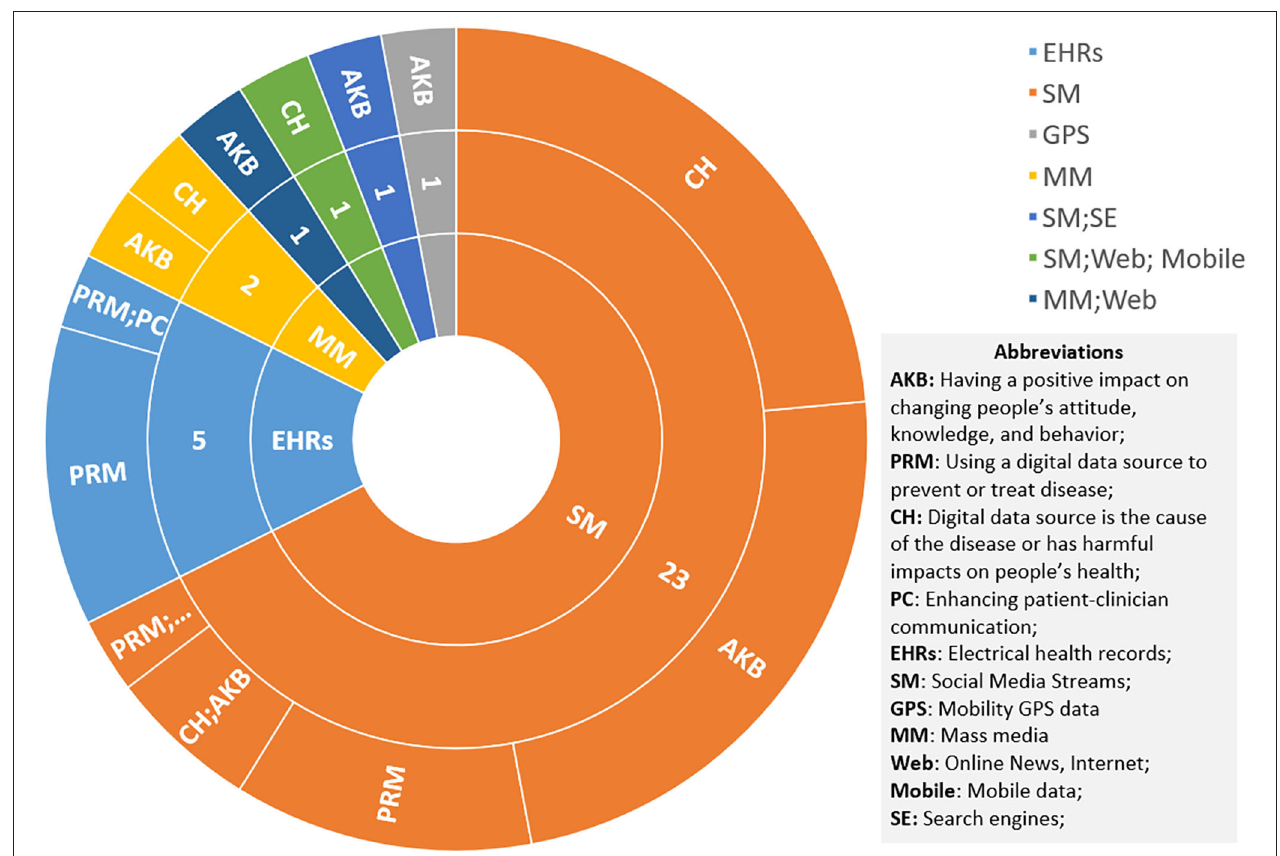
FIGURE 10 | Sunburst chart displaying the impact of each digital source on healthier